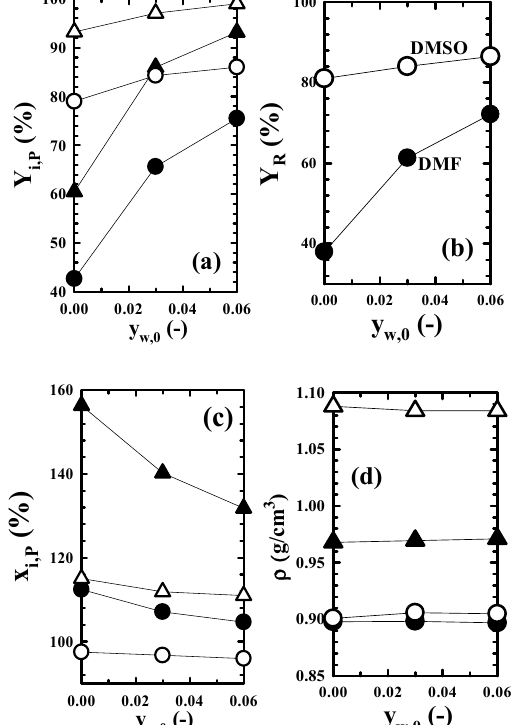
Figure 2. Comparison of solvent for ( a ) recovery rate of paraffin component i (Y i,P ) present in raffinate, ( b ) recovery rate of raffinate (Y R ), ( c ) the concentration increase rate of the paraffin component i ( x i,P ) present in raffinate to that present in raw material (WPPO distillate), and ( d ) density ( ρ ) of raffinate and extract phase according to mass fraction of water in solvent of initial state (y w,0 ). Experimental conditions: t = 72 h, (S/F) 0 = 3, T 0 = 28 °C. Keys of ( a ) and ( c ): ● C 12 (DMF), ▲ C 16 (DMF), ○ C 12 (DMSO), △ C 16 (DMSO). Keys of ( d ): ● ra ffi nate phase (DMF), ○ raffinate phase (DMSO), ▲ extract phase (DMF), (cid:52) extract phase